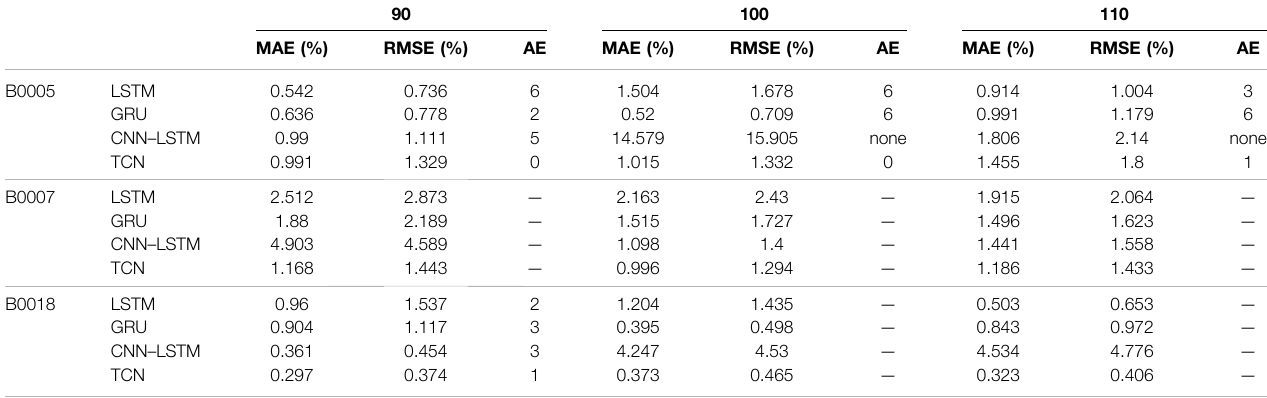
TABLE 4 | SOH prediction effect under different prediction starting points and algorithm combinations.